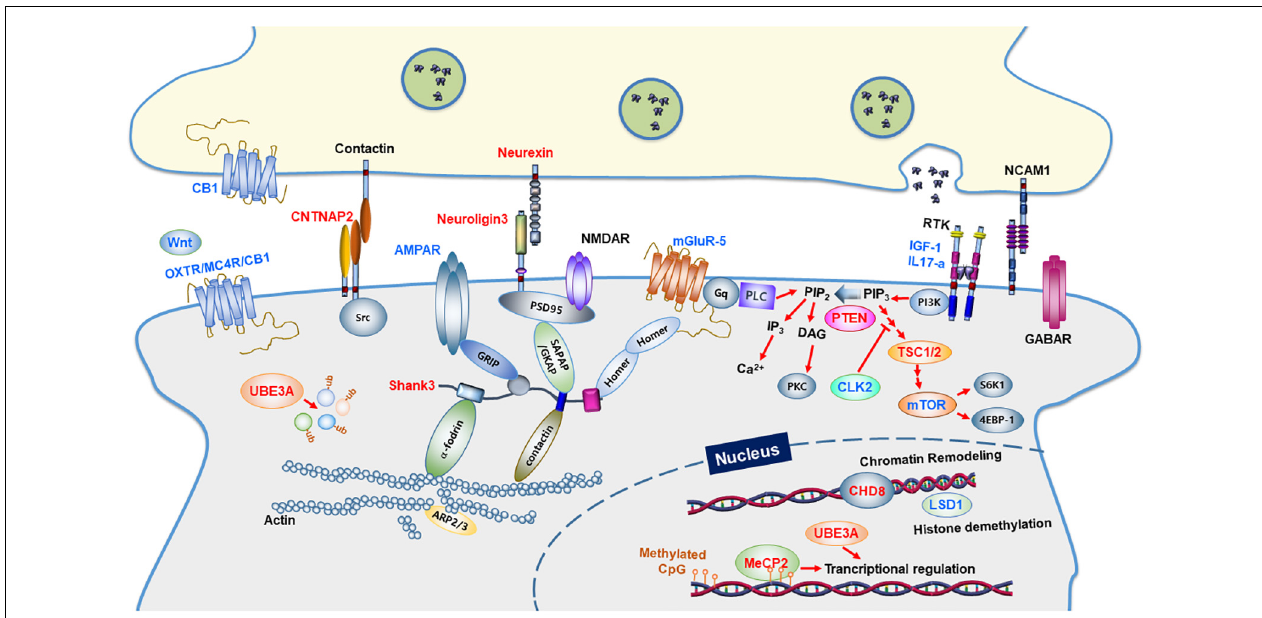
FIGURE 1 | Synaptic proteins and signaling pathways linked to autism spectrum disorders. Synaptic proteins associated with ASD are involved in synapse formation and synaptic function. The ASD-linked proteins covered in this review article are highlighted in red. Proteins in blue indicate molecular targets that were used to ameliorate the ASD phenotype. CB1, Cannabinoid receptor type 1; OXTR, Oxytocin Receptor; MC4R, Melanocortin 4 Receptor; PLC, Phospholipase C; GABAR, GABAA receptor; AMPAR, AMPA receptor; NMDAR, NMDA receptor; mGluR, metabolic glutamate receptor; IGF-1, Insulin-like growth factor 1; IL17A, Interleukin 17A; NCAM1, Neural Cell Adhesion Molecule 1; GRIP1, Glutamate Receptor Interacting Protein 1; SHANK3, SH3 and multiple ankyrin repeat domains 3; SAPAP, Synapse-Associated Protein 90/Postsynaptic Density-95-Associated Protein; GKAP, guanylate-kinase-associated-protein; PSD-95, post-synaptic scaffolding protein 95 kDa; CNTNAP2, a contactin-associated protein-like 2 gene; PI3K, phosphoinositide-3 kinase; CLK2, CDC Like Kinase 2; PTEN, phosphatase and tensin homologs; TSC, tuberous sclerosis complex; mTOR, a mammalian target of rapamycin; CHD8, chromodomain helicase DNA binding protein 8; MeCP2, methyl CpG binding protein 2; LSD1, lysine-specific demethylase 1; UBE3A, Ubiquitin Protein Ligase